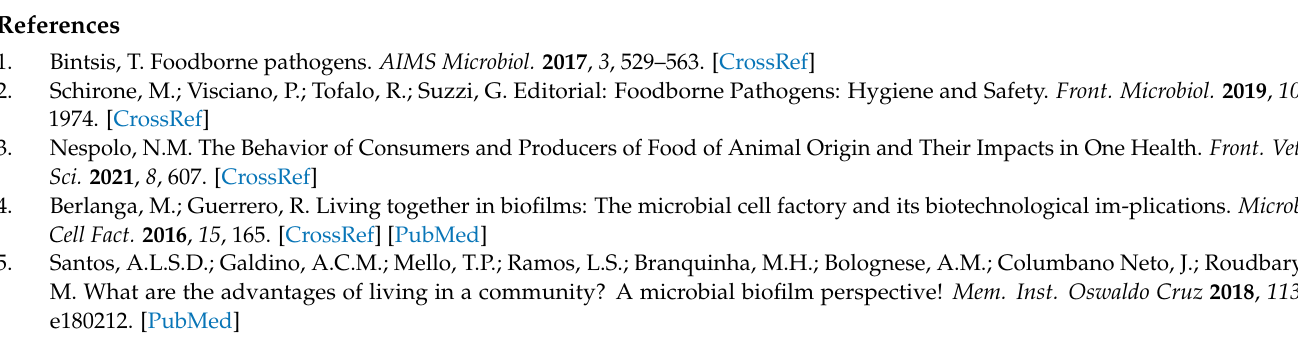
growth., Figure S1: Inhibition effect of PdNPs on planktonic growth. Figure S2: Inhibition effect of PdNPs on biofilm formation. Figure S3: Quantification of biofilm formation with the use of 10 different PdNPs concentrations. Table S2: Absorbance values (A 620 ) of the effect of PdNPs on further growth of biofilm cells. Figure S4: Inhibition effect of PdNPs on further growth of biofilm cells. Figure S5: Reduction effect of PdNPs on preformed biofilms. Figure S6: Quantification of biofilm reduction with the use of 6 different PdNPs concentrations. Table S3: Absorbance values (A 620 ) of the effect of PtNPs on planktonic growth. Figure S7: Inhibition effect of PtNPs on planktonic growth. Figure S8: Inhibition effect of PtNPs on biofilm formation. Figure S9: Quantification of biofilm formation with the use of 10 different PtNPs concentrations. Table S4: Absorbance values (A 620 ) of the effect of PtNPs on further growth of biofilm cells. Figure S10: Inhibition effect of PtNPs on further growth of biofilm cells. Figure S11: Reduction effect of PtNPs on preformed biofilms. Figure S12: Quantification of biofilm reduction with the use of 6 different PtNPs